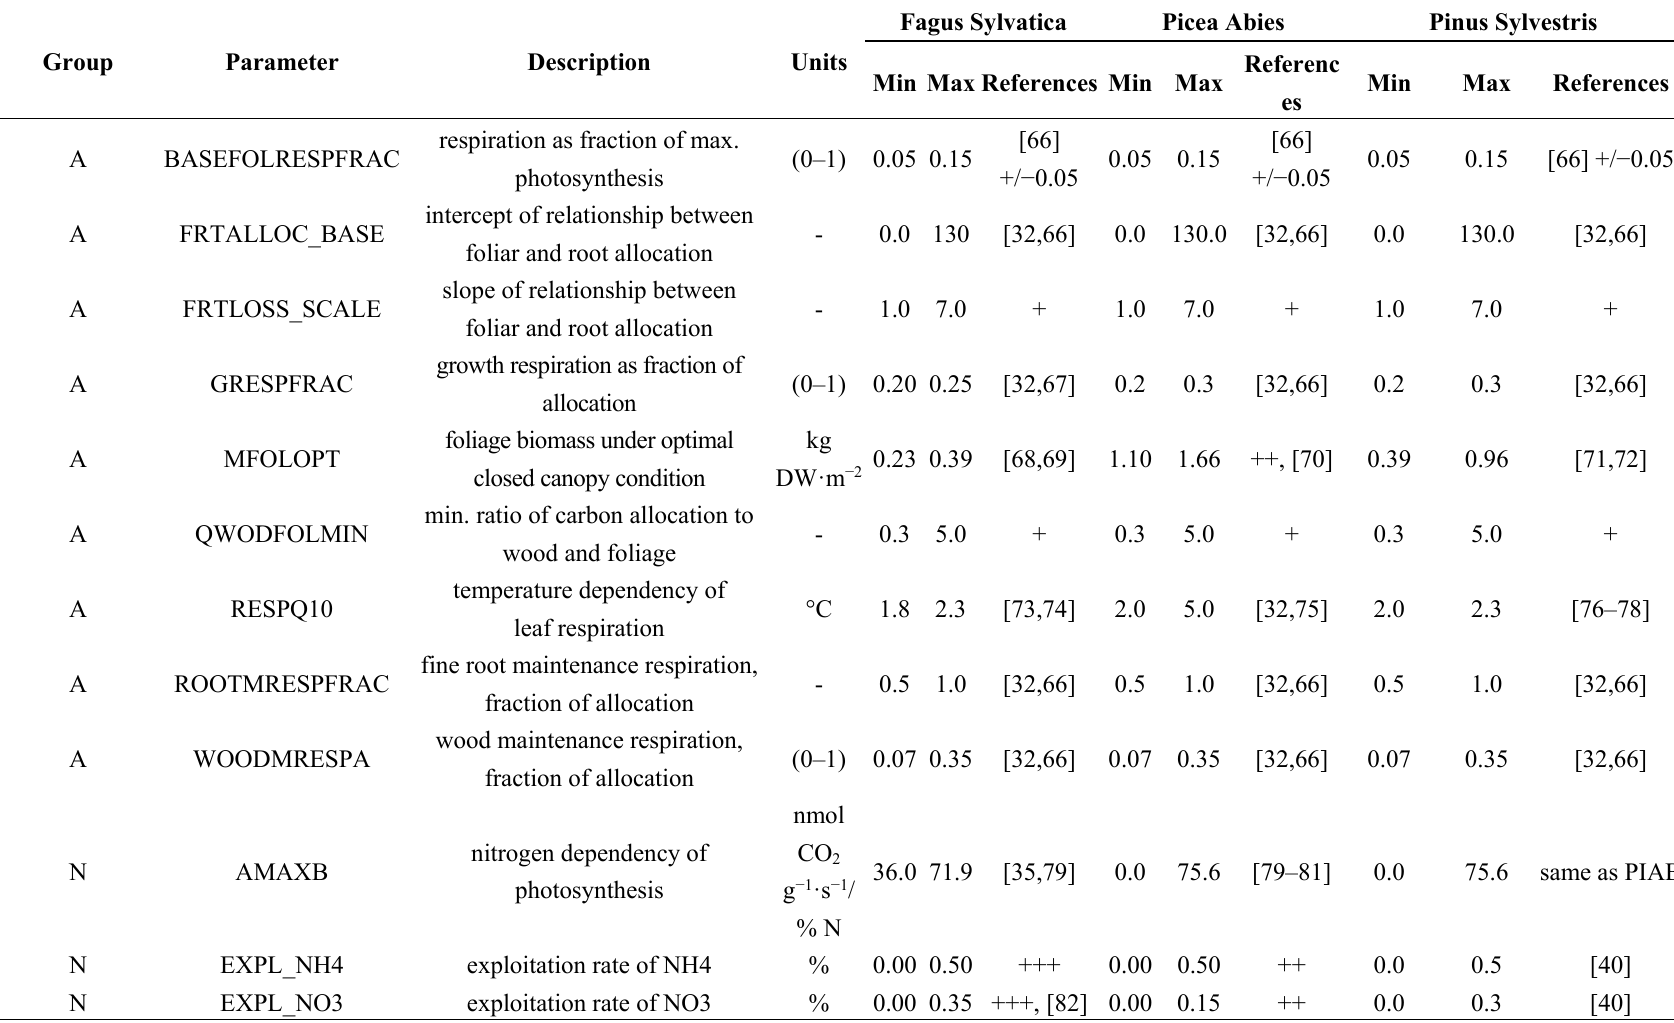
Table 2. Summary of physiological parameters subject to calibration, description and value ranges. In case no publications were found, we refer to our own parameter adjustments to specific sites. Parameters are grouped by carbon allocation and respiration (A), nitrogen (N), temperature (T) and water availability and light extinction